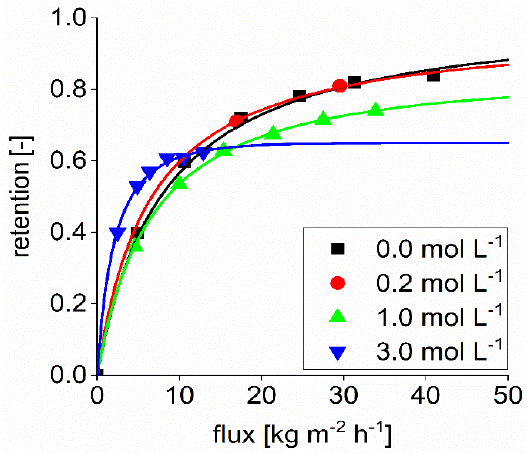
Figure 4. Retention of sulfate in pure water and in mixtures of different NaOH concentrations at 40 °C. The dots indicate experimental data, the solid line shows the Spiegler and Kedem fit.